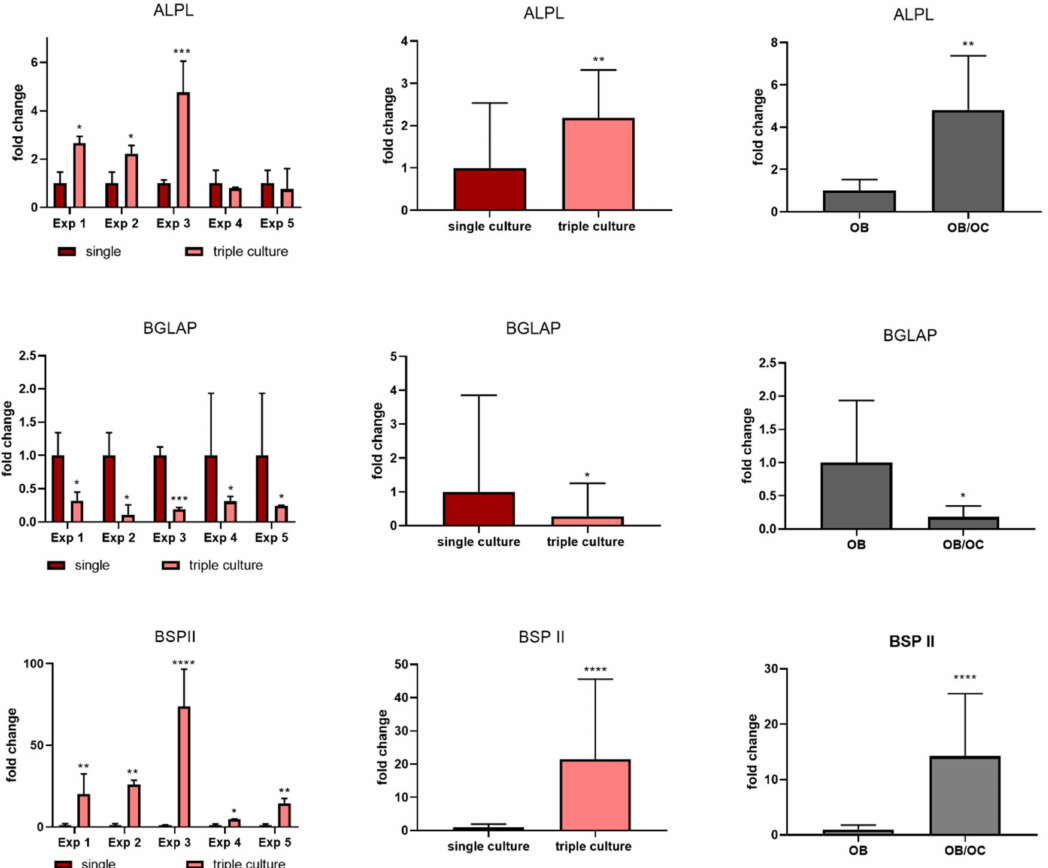
Figure 6. Gene expression analysis of osteoblast marker genes ALPL, BGLAP and BSPII for osteoblasts cultivated in single culture compared to triple culture with osteoclasts and osteocytes. Gene expression was normalized to the expression of GAPDH and fold changes were calculated using the ∆∆ CT method. Fold changes +/ − upper and lower limits for the single experiments (left column) and for all five experiments together (middle column). Additionally, osteoclasts derived from two different donors were combined with osteoblasts of one donor in two independent experiments in co-culture (right column). * p < 0.05; ** p < 0.01, *** p < 0.001, **** p < 0.0001.